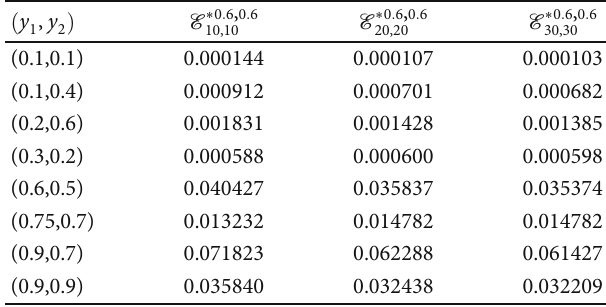
Table 2: Error of approximation E ∗ λ 1 , λ 2 30 and q 1 = q 2 = 0 : 8 and λ 1 = λ 2 = 0 : 6